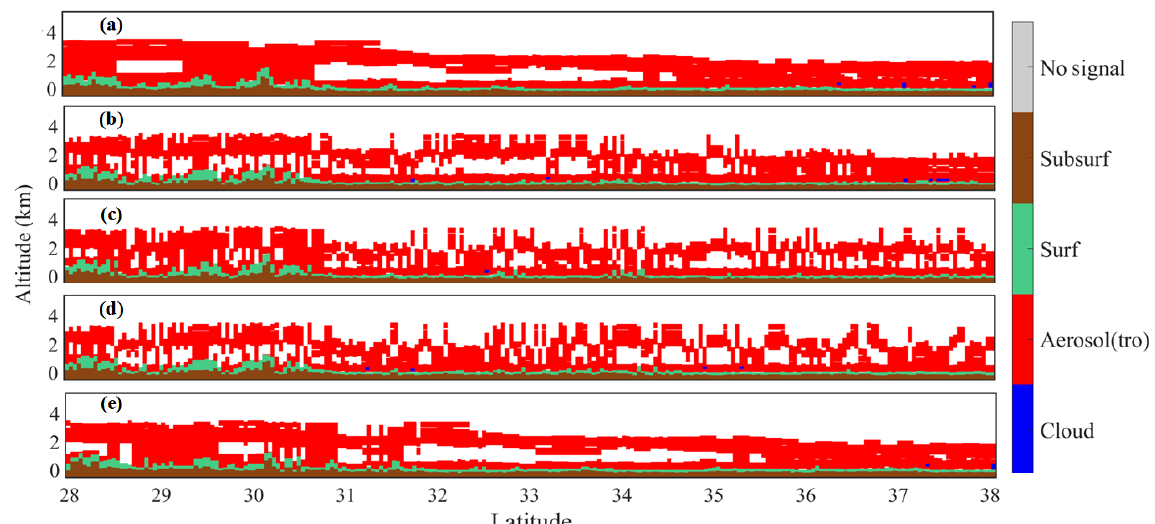
Figure 1. Reconstruction of CALIPSO profile passing the eastern coast of China on 3 January 2015 with dead-zone setting for 100km. The panels show the original profile and reconstructed profiles using different combinations of radiance bands.